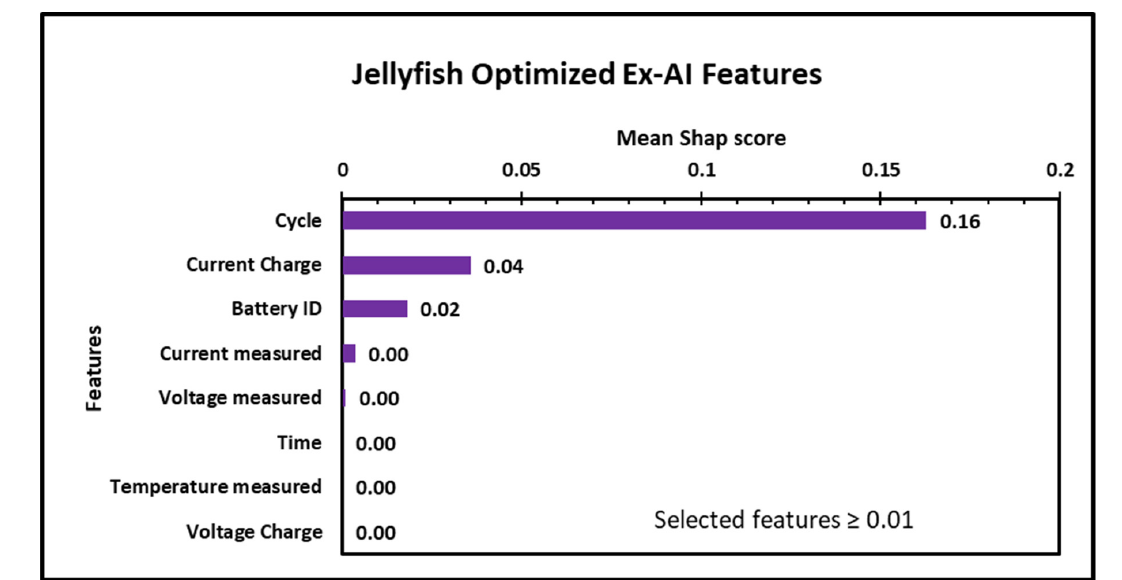
Figure 9. Features selected with Ex-AI model.